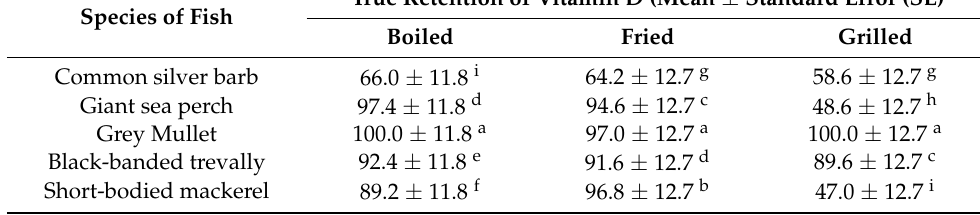
Table 6. Cont. True Retention of Vitamin D (Mean ± Standard Error (SE) Species of Fish Boiled Fried Grilled Common silver barb 66.0 ± 11.8 i Giant sea perch Black-banded